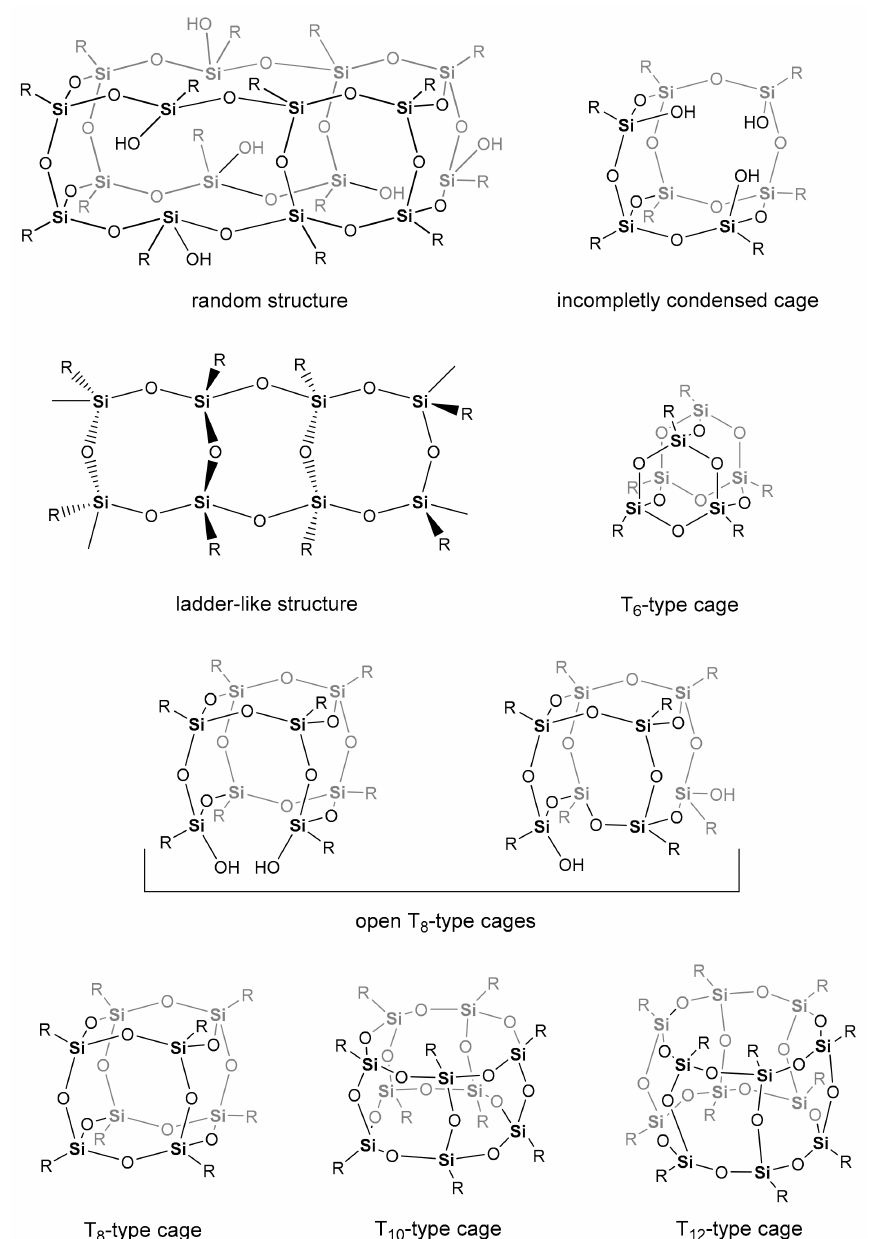
Figure 1. Selected examples of silsesquioxanes’